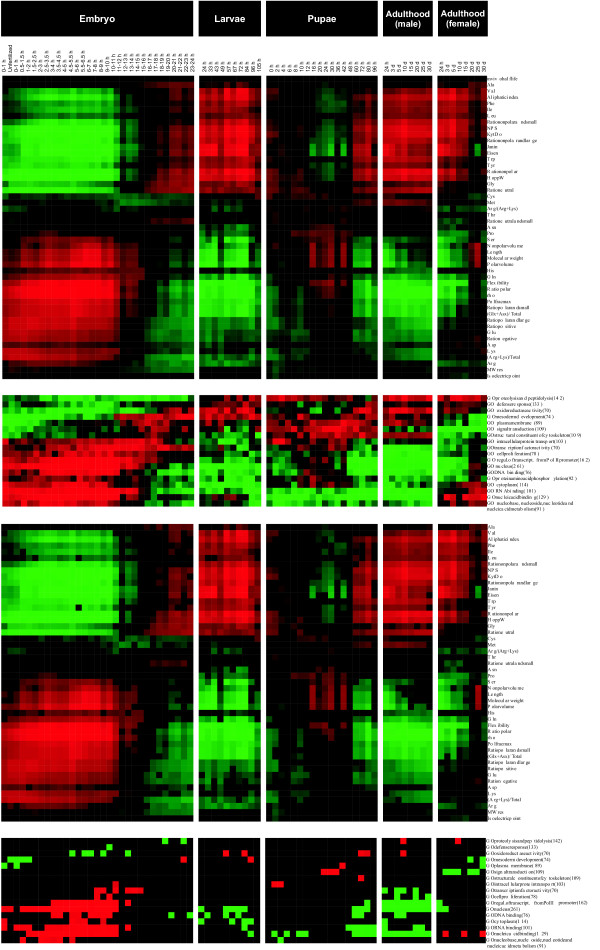
Data analysis of the D. melanogaster life cycle. (Top) Correlation coefficients of 2,976 genes in wild-type flies examined at 66 time points beginning at fertilization and spanning the embryonic, larval, and pupal periods as well as the first 30 days of adulthood. (Bottom) The most significant cases are shown. Two transition periods are apparent from the correlations. The continuity and strength of the correlations are unique to the D. melanogaster data.